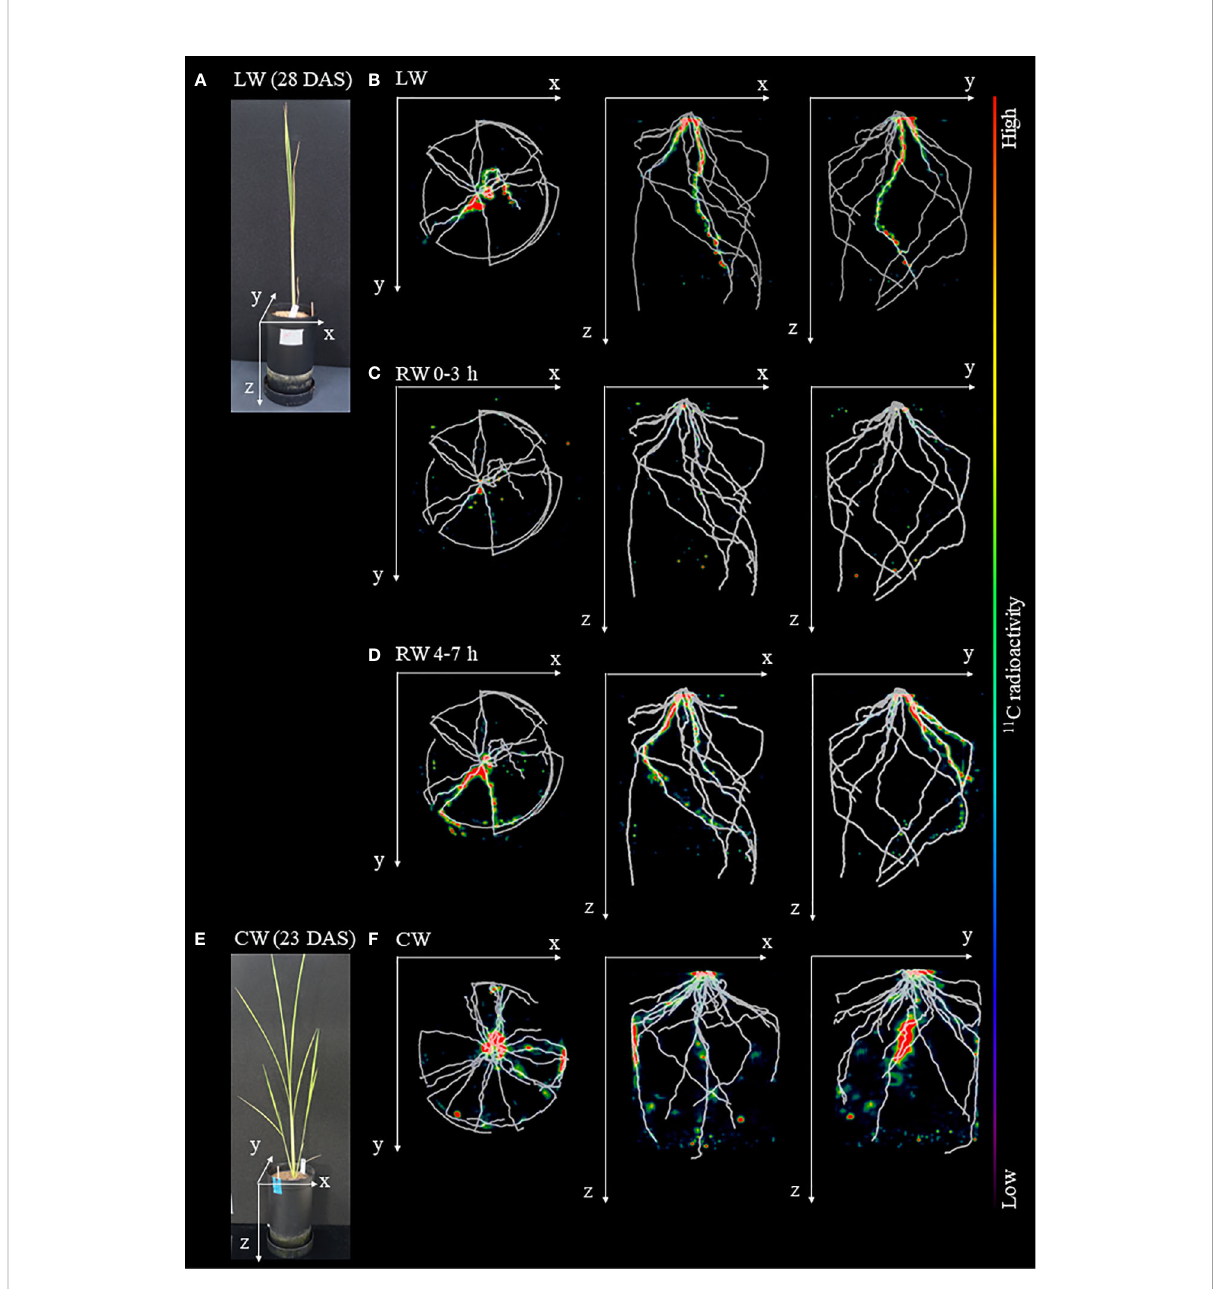
FIGURE 4 Fused images obtained from OpenPET imaging experiments and X-ray CT. (A) Photograph of rice plants under drought condition before the start of OpenPET imaging at 28 DAS. Fused images of the distribution of 11 C-photosynthates obtained from OpenPET imaging and root system architecture (RSA) of plants growing under in (A) obtained from X-ray CT under (B) low water content (LW), (C) recover water content 0-3 h (RW 0-3 h), and (D) recover water content 4-7 h (RW 4-7 h), viewed from the top of the pot (xy plane), front of the pot (xz plane), and side of the pot (yz plane). Images obtained from OpenPET imaging experiments under the control water content (CW) are also shown. (E) Photograph of rice plants under CW at 23 DAS. (F) Fused images obtained from OpenPET and X-ray CT under the CW, viewed from the xy plane, xz plane, and yz plane. The monochrome images show the RSA, and the color images show the distribution of 11